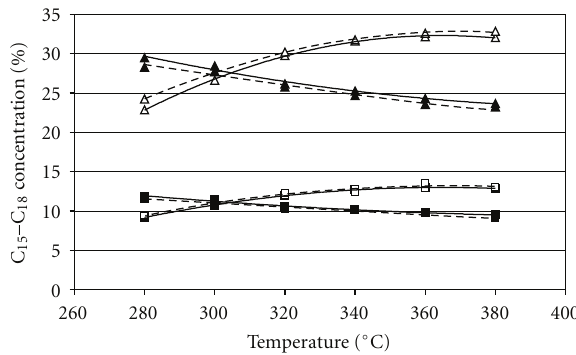
Figure 6: The concentration of the C 15 –C 18 para ffi ns of the intermediate product; where: fraction (broken line: P = 20bar, continuous line: P = 80bar) (LHSV = 1.0h − 1 , H 2 /feedstock volume ratio = 600Nm 3 /m 3